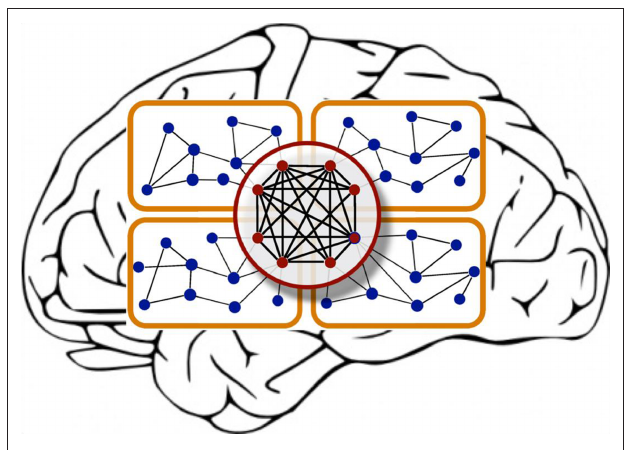
Figure 1 | The cartoon illustrates two important features of hierarchical brain networks: modules and hubs. Adapted from Zamora-López et al.